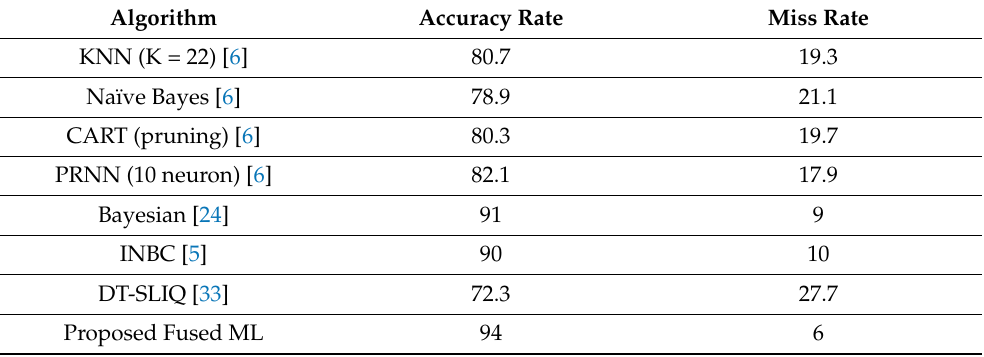
Table 14. Comparison of proposed fusion model with previously published